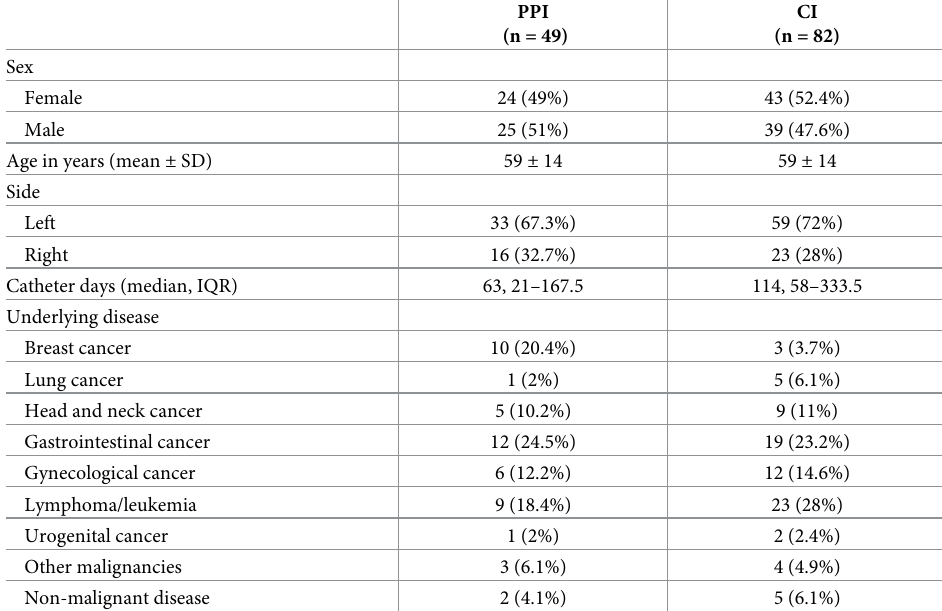
Table 2. Case characteristics of port pocket infections (PPI) and catheter infections